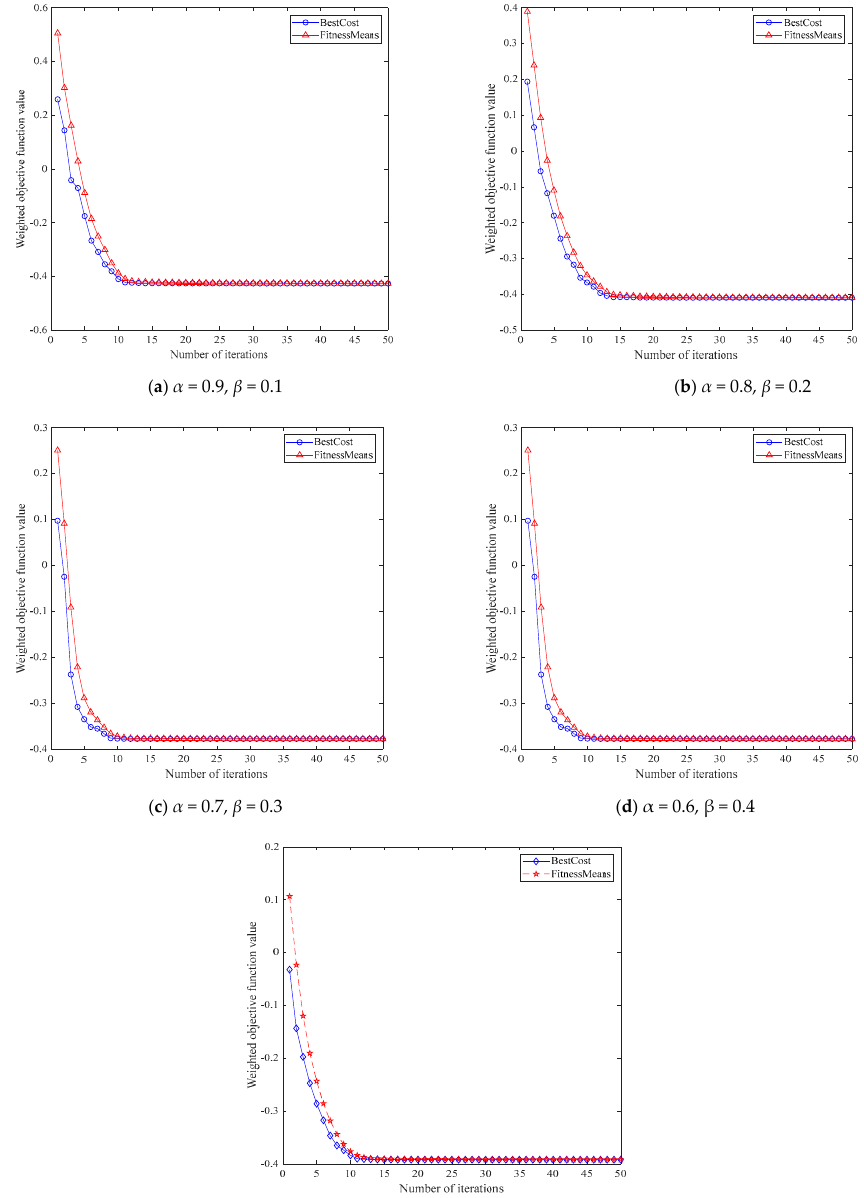
Figure 10. The change curve of the weighted objective function value corresponding to the weight ratio.